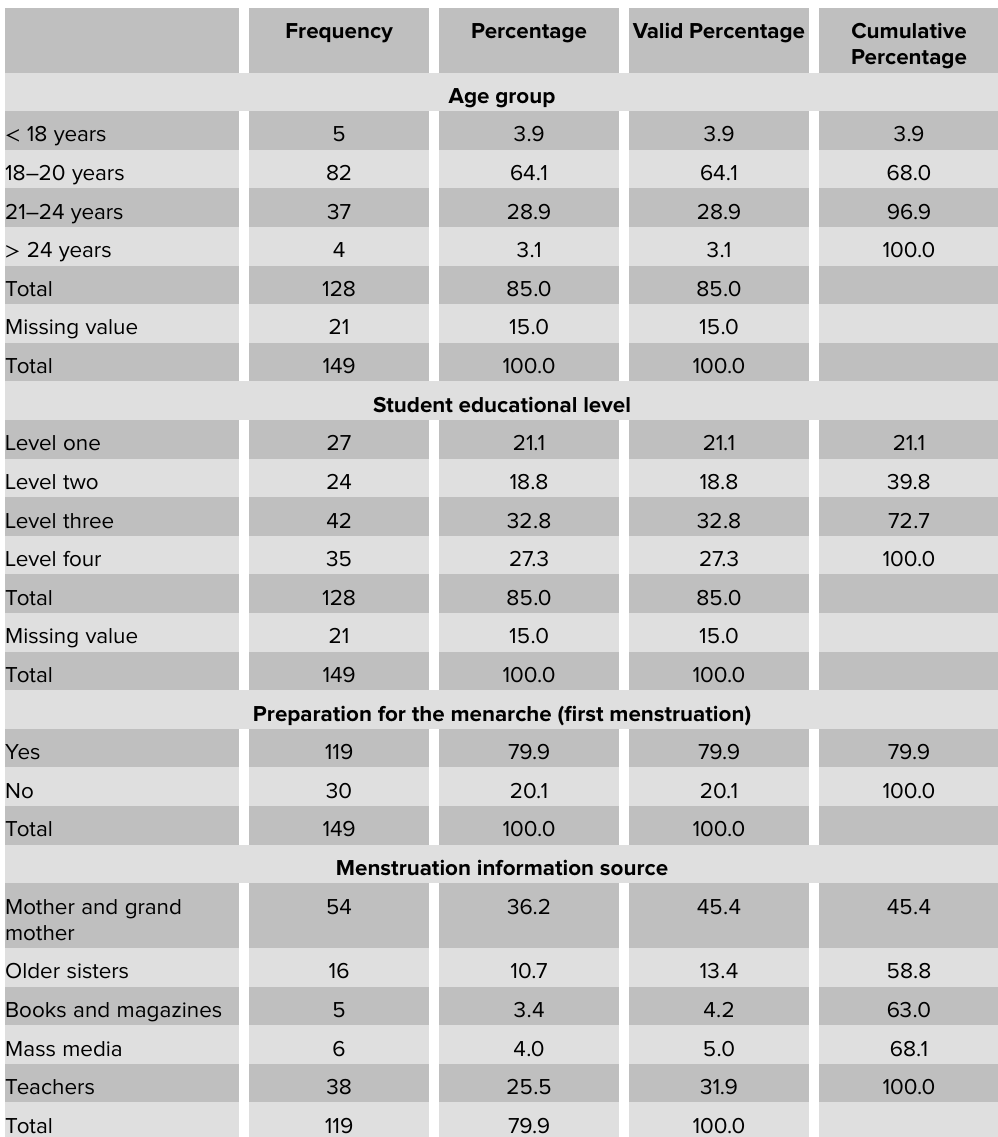
TABLE 1: Background characteristics ( n =